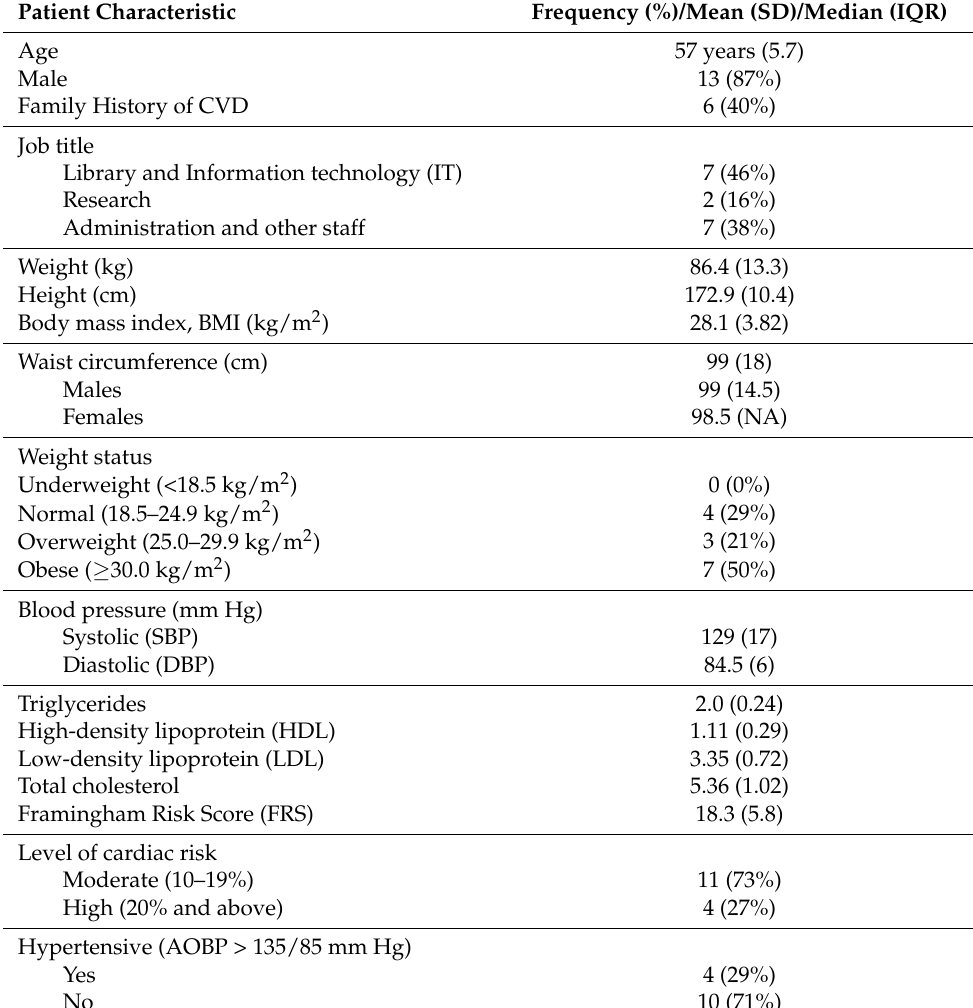
Table 1. Characteristics of patients in the second pharmacist-led CVD prevention